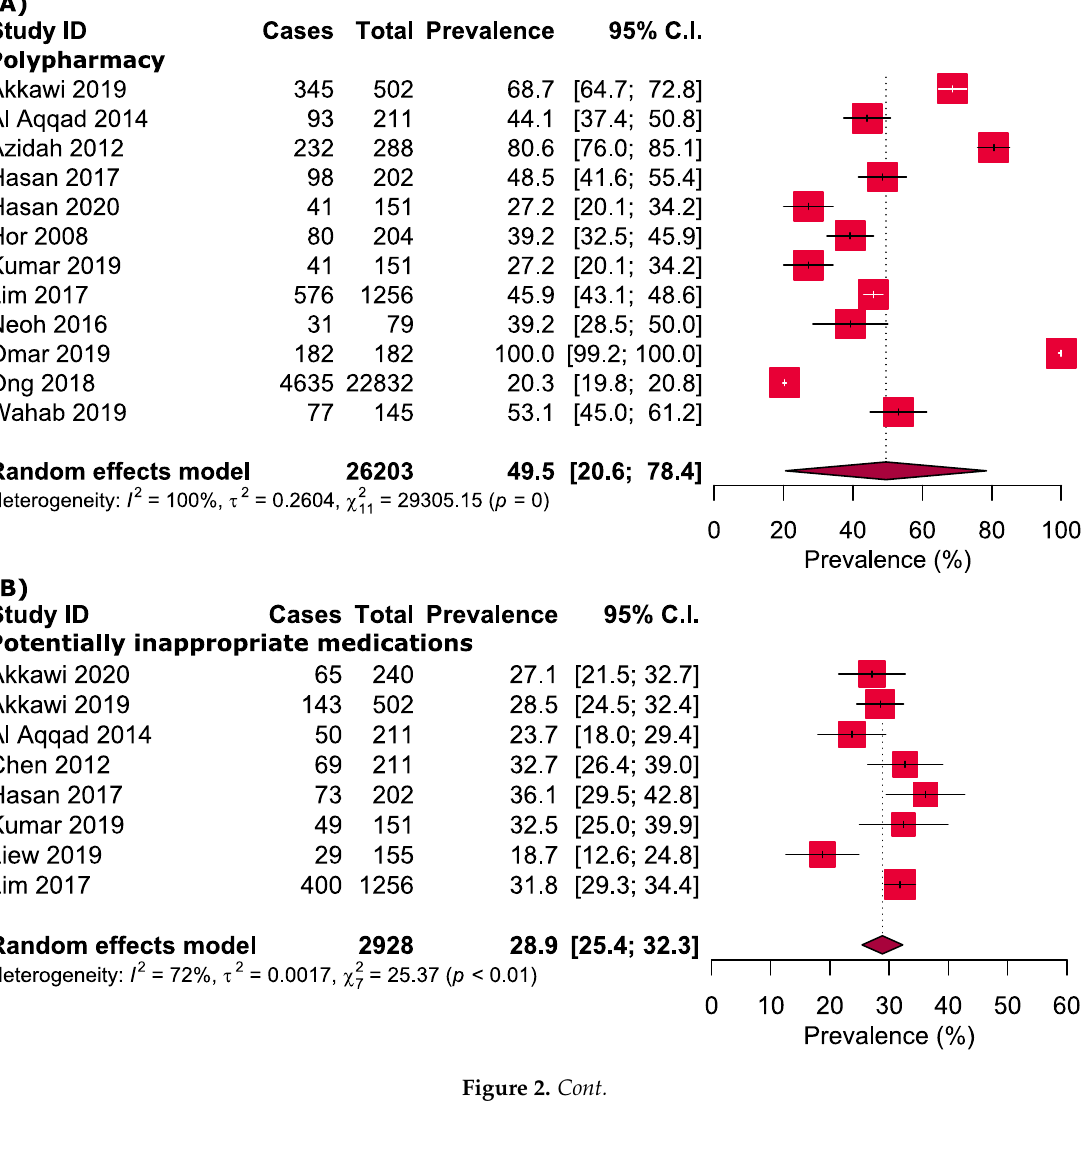
(Figure 2). Elderly who frequented the health facilities [72.5% (95% CI: 61.9–83.0)] and stayed in the Central region of the country [55.7% (95% CI: 46.7–64.8)] reported a higher prevalence of CAM use as compared with those from the community [46.0% (95% CI: 32.0–59.9)] and the Eastern region [33.2% (95% CI: 28.6–37.9)] (Table 2 and Figure S1).